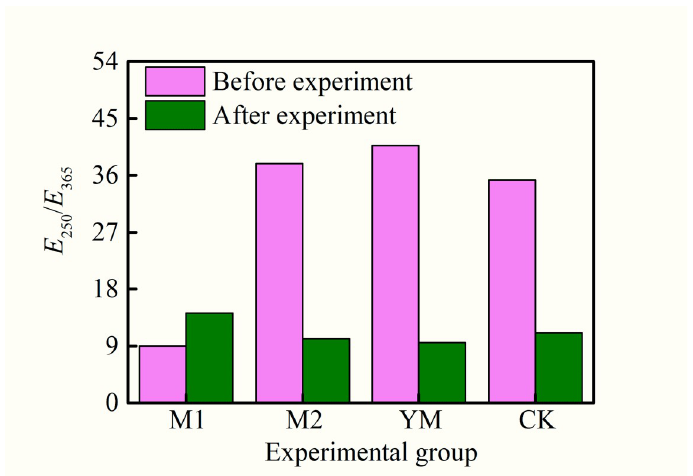
Fig 4. The changes of E 250 /E 365 before and after biogenic methane